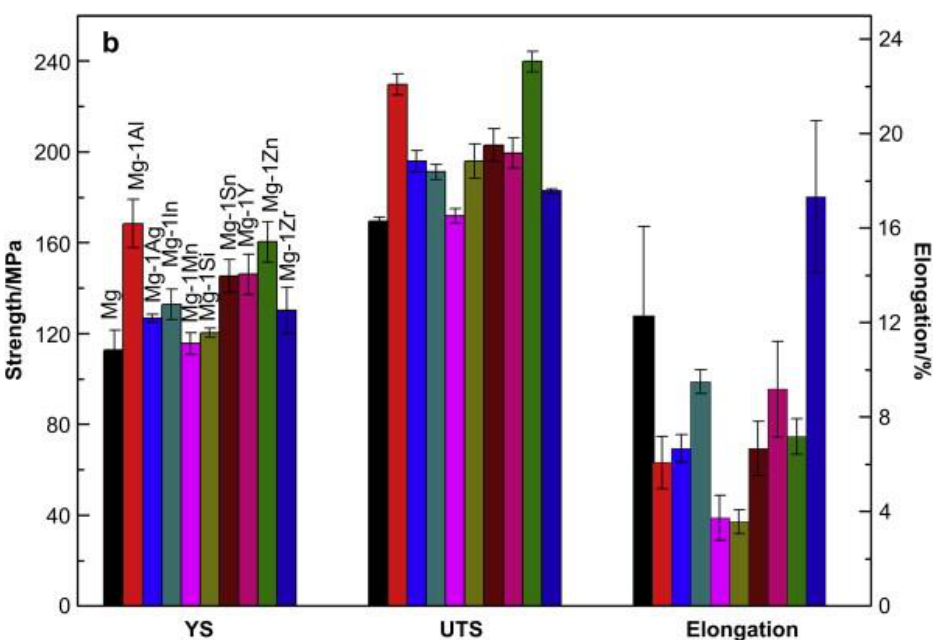
Figure 6. Tensile properties of ( a ) as-cast and ( b ) as-rolled pure Mg and Mg–1X alloy (X = Al, Ag, In, Mn, Si, Sn, Y, Zn, and Zr) samples at room temperature [62].